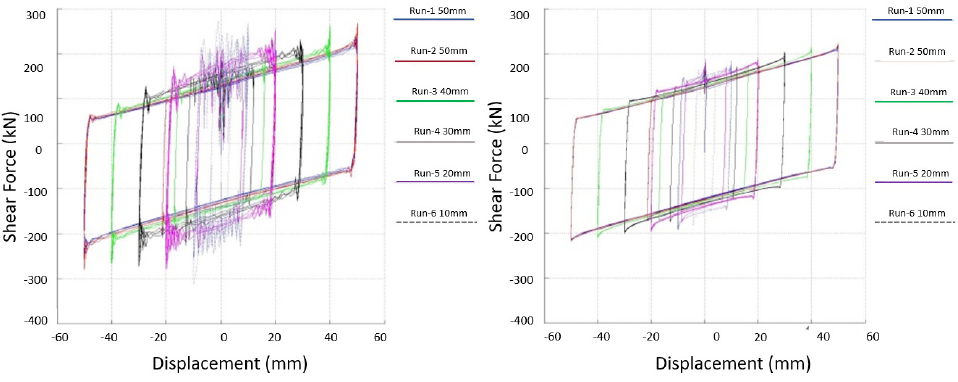
Figure 11. Cyclic test results of curved surface friction slider units for the pseudo-dynamic testing [42].